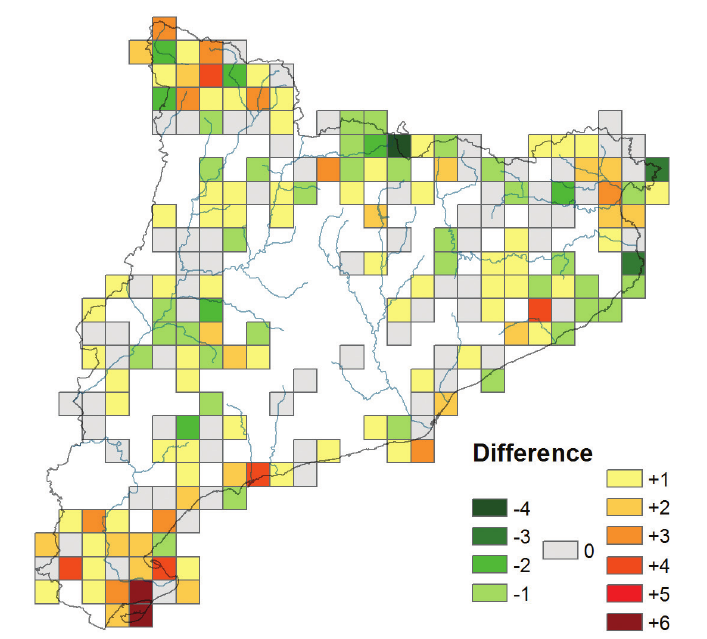
Figure 6. Comparative map of the number of taxa of the dataset and that according to Sáez et al. (2010: 733). Gray color indicates that all the taxa cited in this book have a specimen in the herbaria studied; yellow-red color indicates that the dataset doesn’t include all the taxa published in this book and green color indicates that there are more taxa in the dataset that those published in this